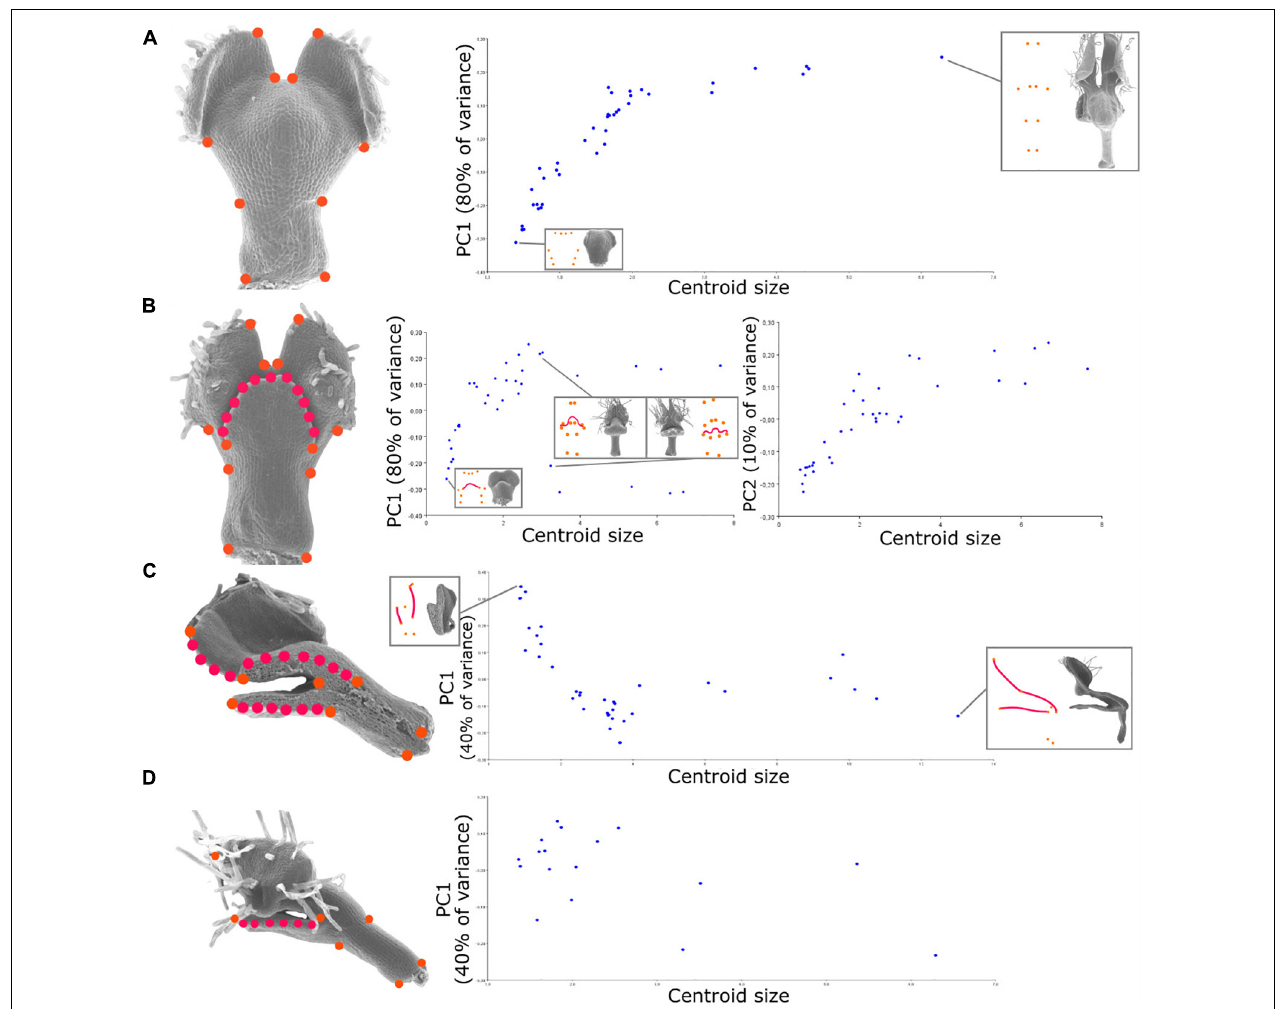
FIGURE 2 | Relationship between shape and size during petal development revealed by geometric morphometrics of the developing N. damascena petal in the four views (i.e., dorsal, ventral, medial, and lateral). On the left side of (A–D) panels, landmark sets are indicated and superimposed to the corresponding petal scanning electron microscopy (SEM) pictures (orange dots are landmarks, and red dots are semi-landmarks). For the four views, the Procrustes analyses are followed by the principal component analysis (PCA), and its first axis (and also the second axis for ventral view) is plotted against centroid size (proxy of petal size). The first axis explains 80% of the variance for dorsal and ventral views and 40% of the variance for medial and lateral views. The percentage of variance explained by an axis corresponds to the ratio between the variance of that principal component and the total